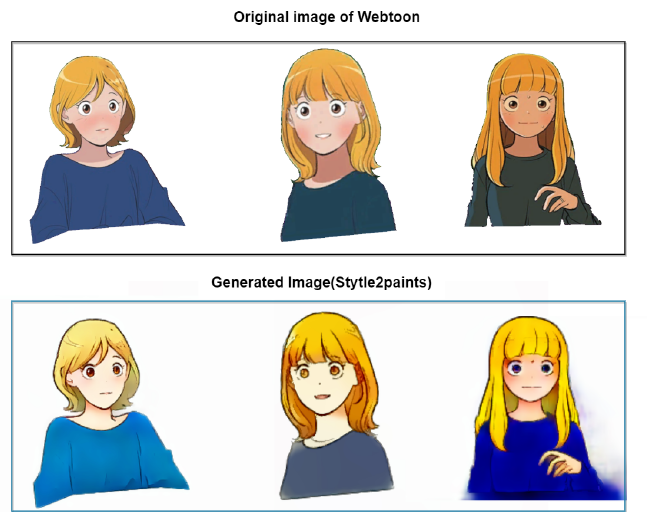
Figure 1. Original images used in a webtoon and a set of generated images by Style2paints, a line art colorization network [7].